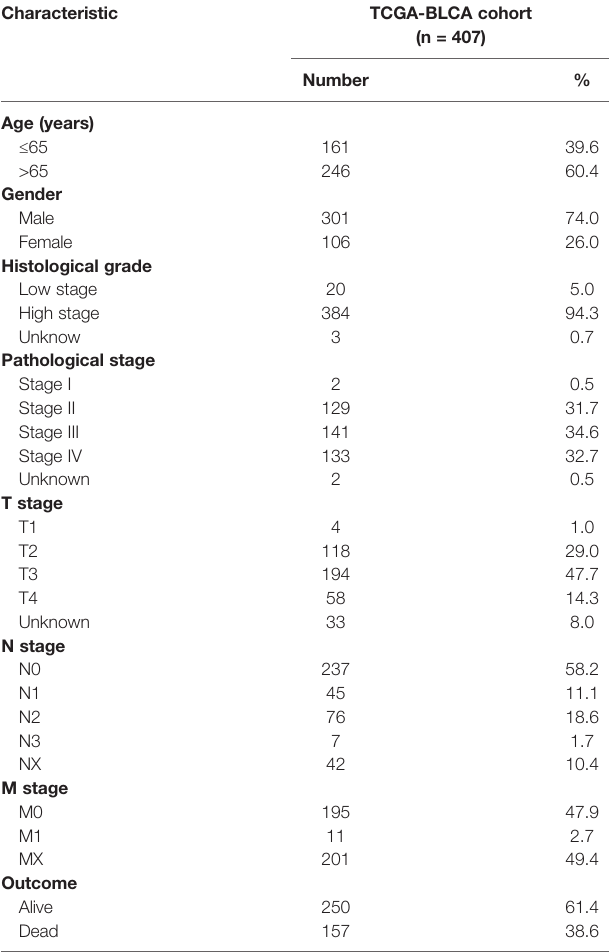
TABLE 2 | Clinicopathological characteristics of patients in TCGA-BLCA cohort.